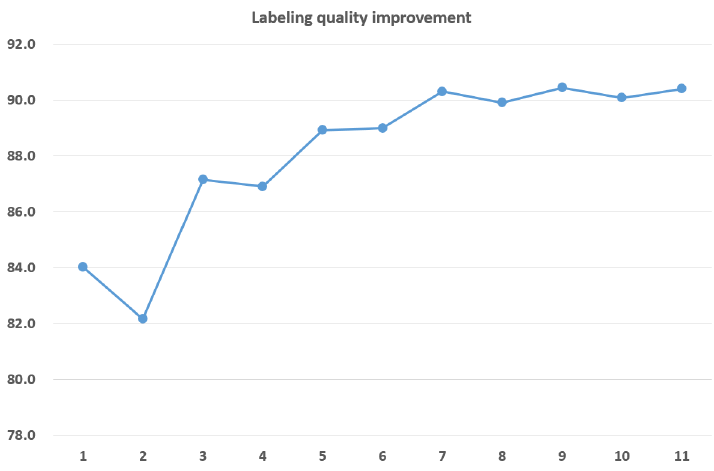
Fig 11. Labeling quality improvement. Change of labeling quality as the number of example subjects increases from one to eleven.